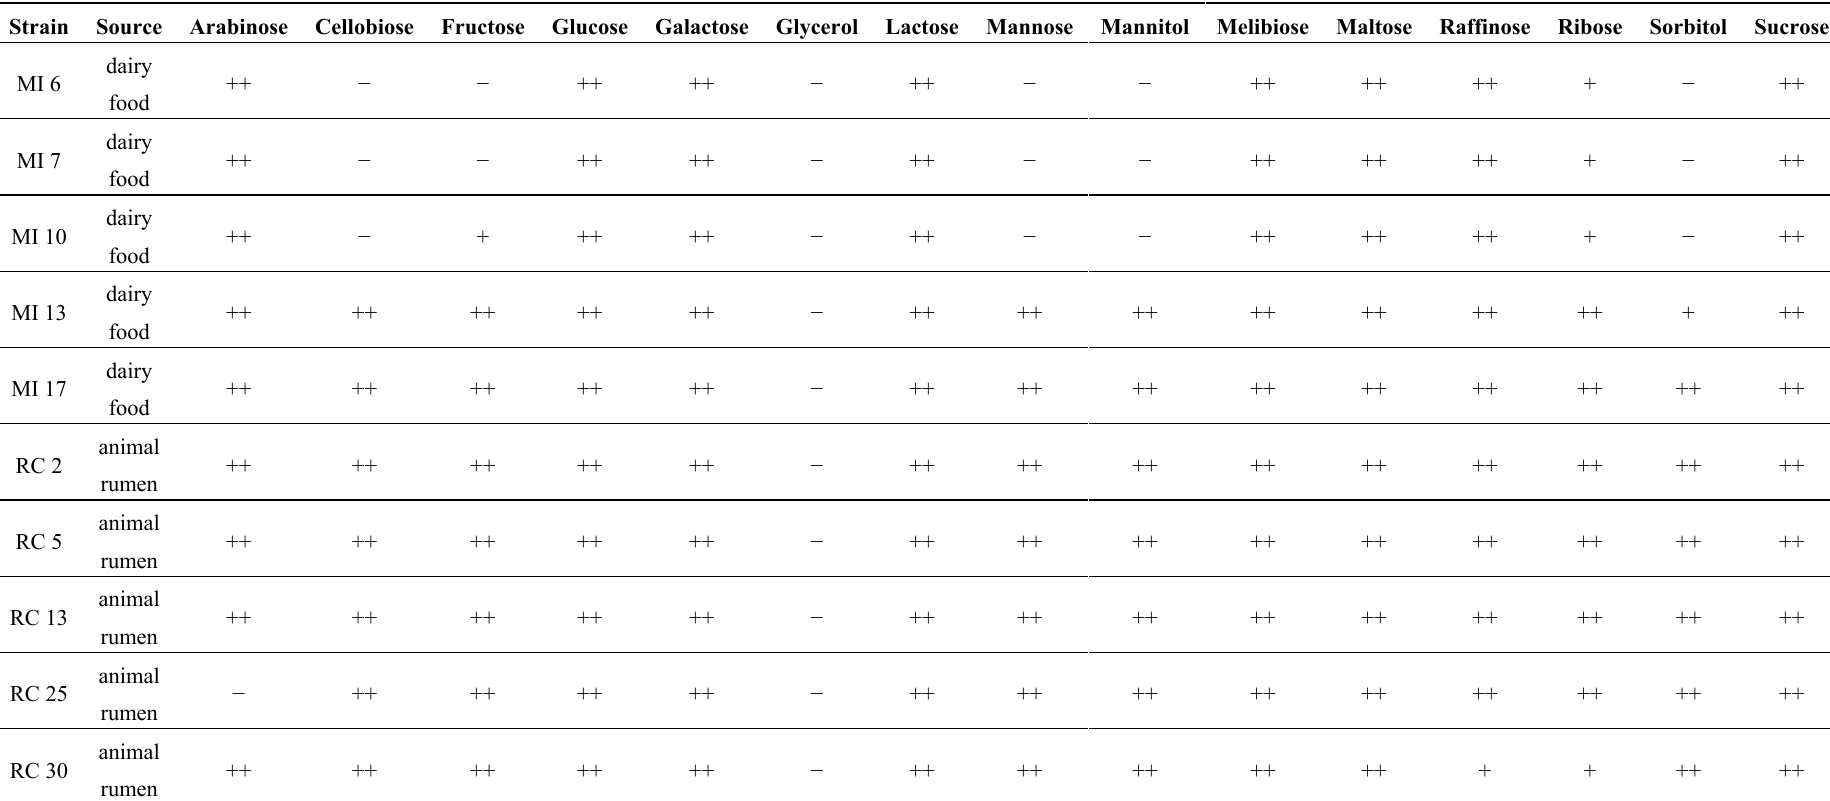
Table 1. Sugar fermentation capacity of each